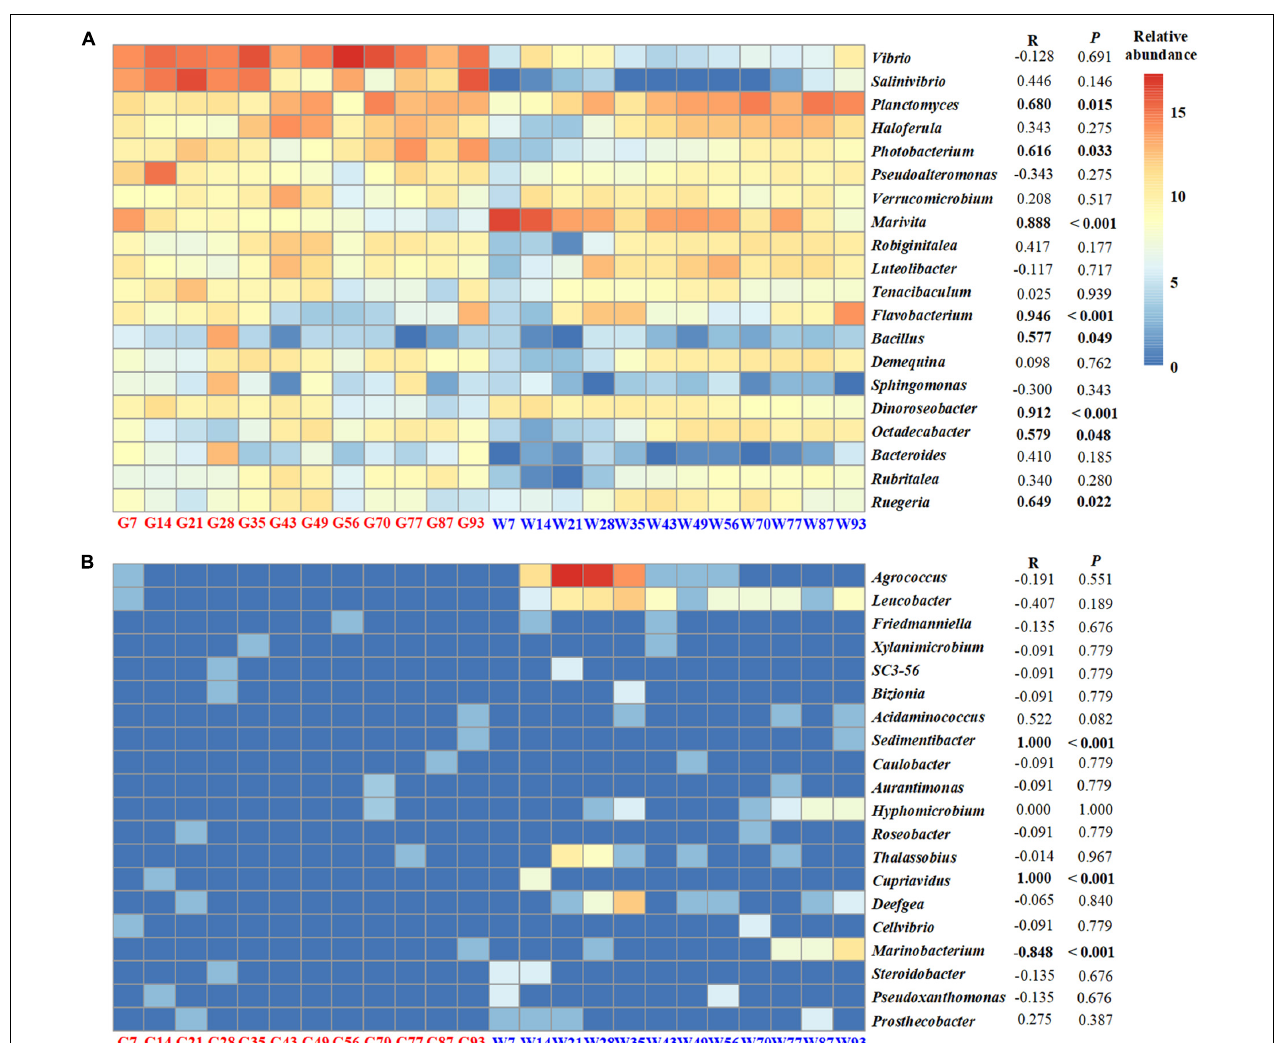
FIGURE 4 | The relative abundances of the top abundant 20 bacterial genera (A) and the most rare 20 bacterial genera (B) in the gut and those in bacterioplankton communities. Pearson’s correlations and the significances of the genera between shrimp gut and rearing water are shown on the